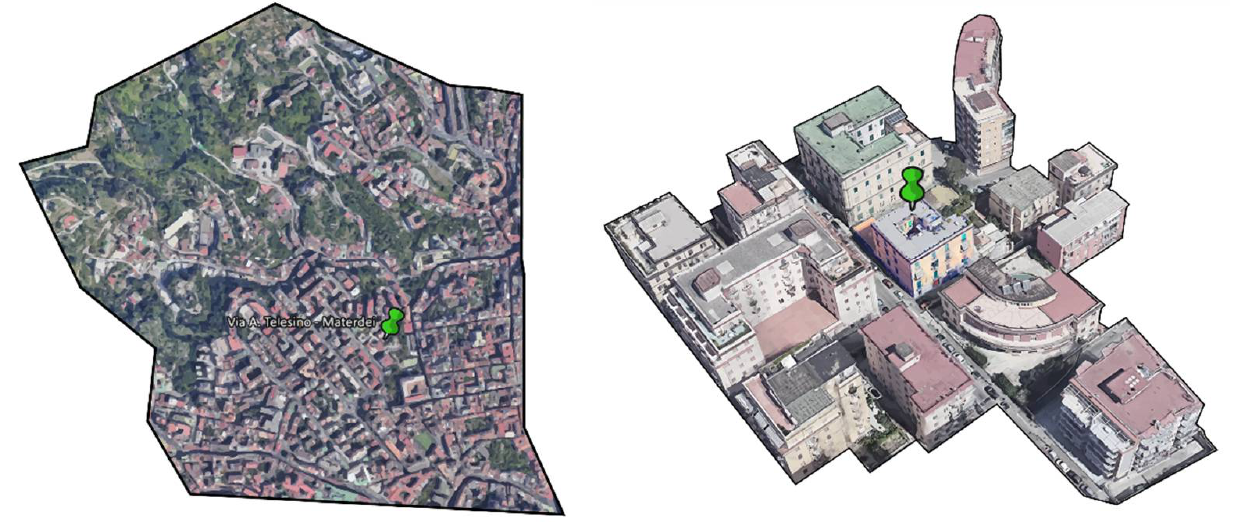
Figure 3. Identification of the Materdei district and the area and building of interest.